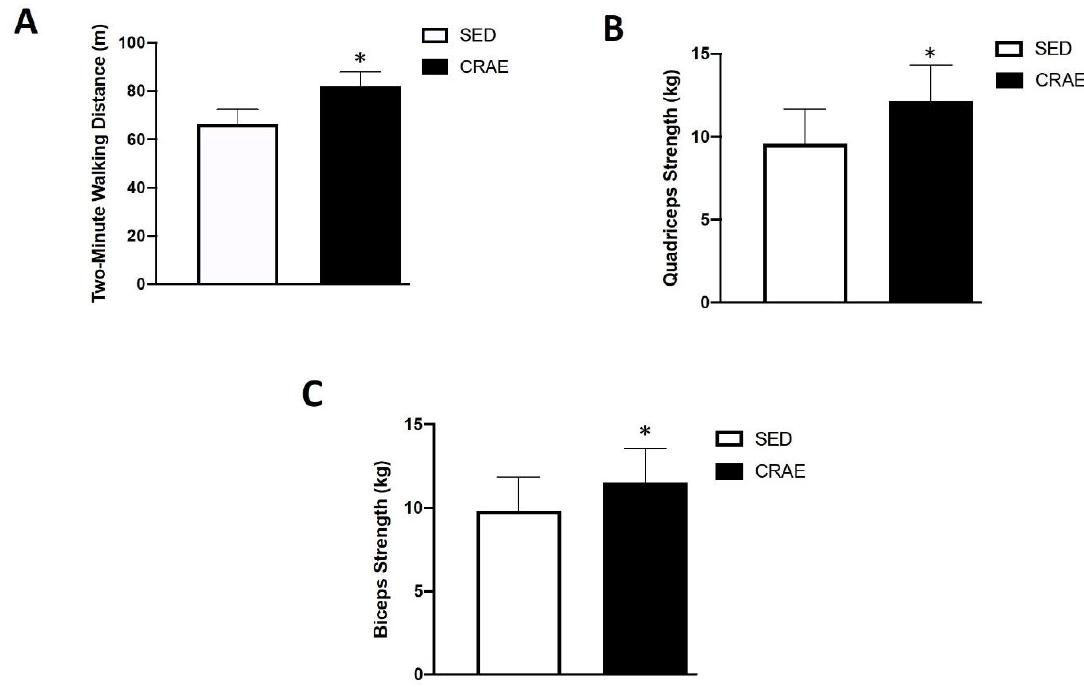
Figure 5. Differences in walking capacity and muscular strength between the combined resistance and aerobic exercise training (CRAE) and sedentary (SED) groups. ( A ) The CRAE group had a significantly greater 2-min walking distance (m) compared to the SED group 66.4 ± 6.1 vs. 82.2 ± 5.7 m, SED vs. CRAE, respectively; p = 0.022) ( B ) The CRAE group had significantly greater single-leg extension quadriceps strength (kg) compared to the SED group (9.6 ± 2.0 vs. 12.2 ± 2.0 kg, SED vs. CRAE, respectively; p = 0.029) ( C ) The CRAE group had significantly greater two-arm curl biceps strength (kg) compared to the SED group (9.8 ± 2.0 vs. 11.5 ± 2.0 kg, SED vs. CRAE, respectively; p = 0.046). Values are Mean ± SD. * p < 0.05 vs.